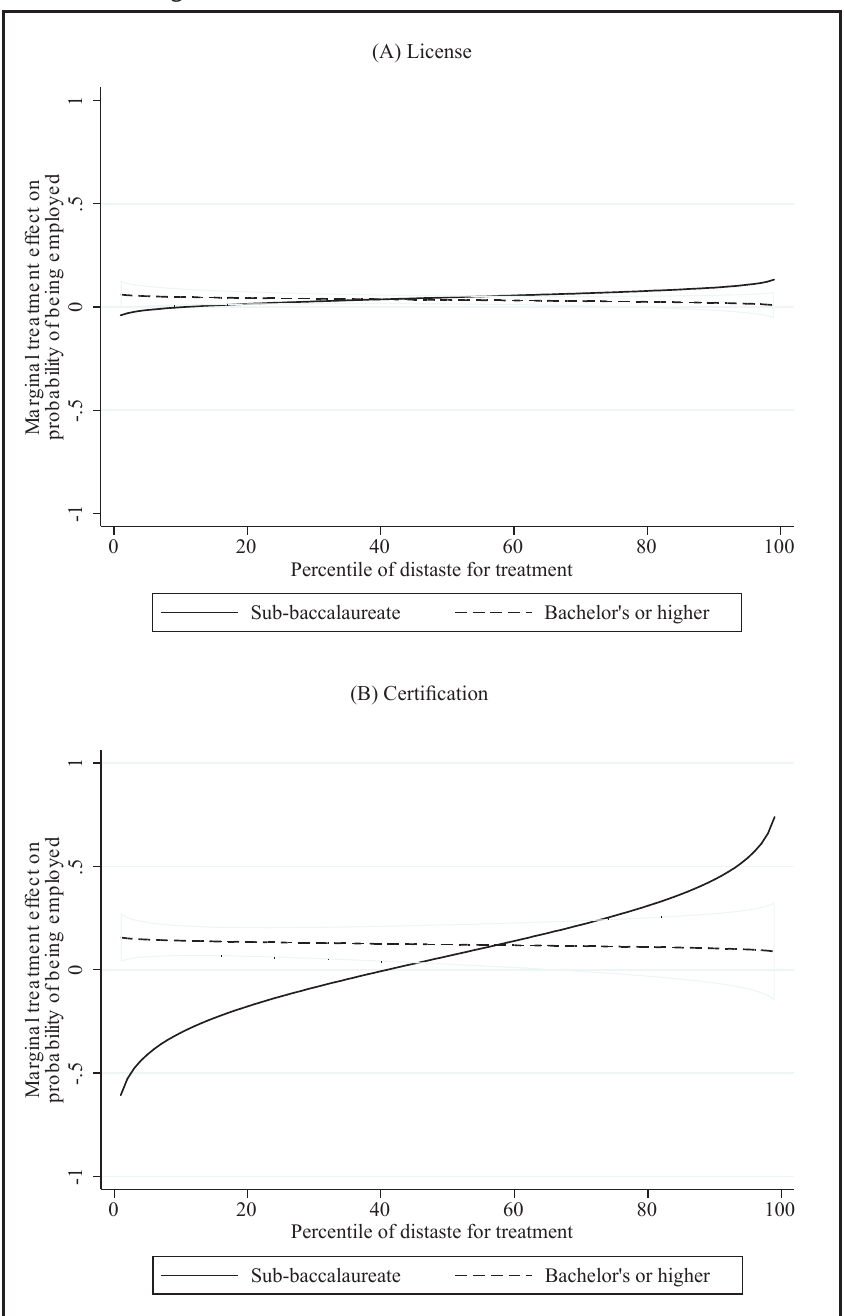
Note : Shaded region represents 95% confidence interval from block-bootstrapping. Results come from estimating MTE model of the marginal impact of credentialing across distaste for treatment on the outcome of probability of being employed. MTEs, marginal treatment